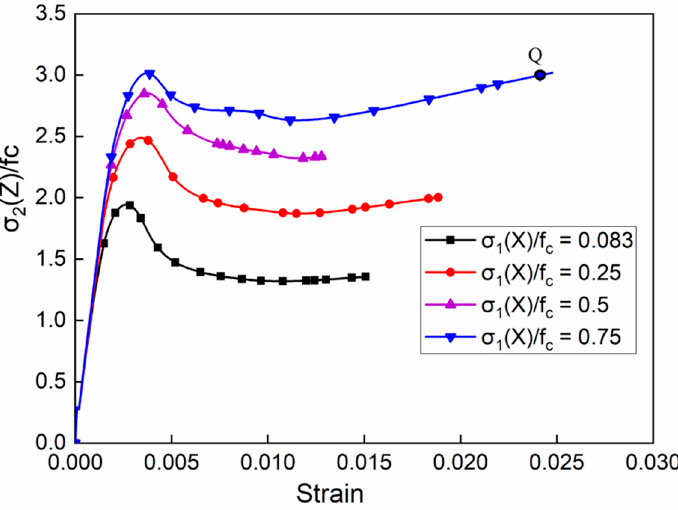
Figure 9. Stress–strain curves of different σ 1 /f c ratios when σ 3 /f c = 0.25.